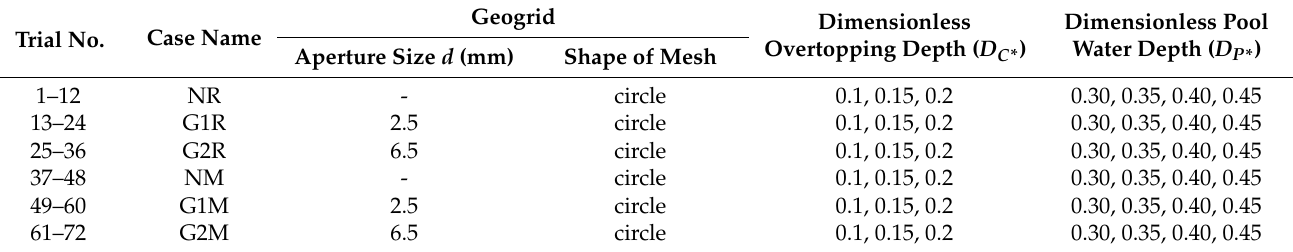
Table 1. Hydraulics and geometric